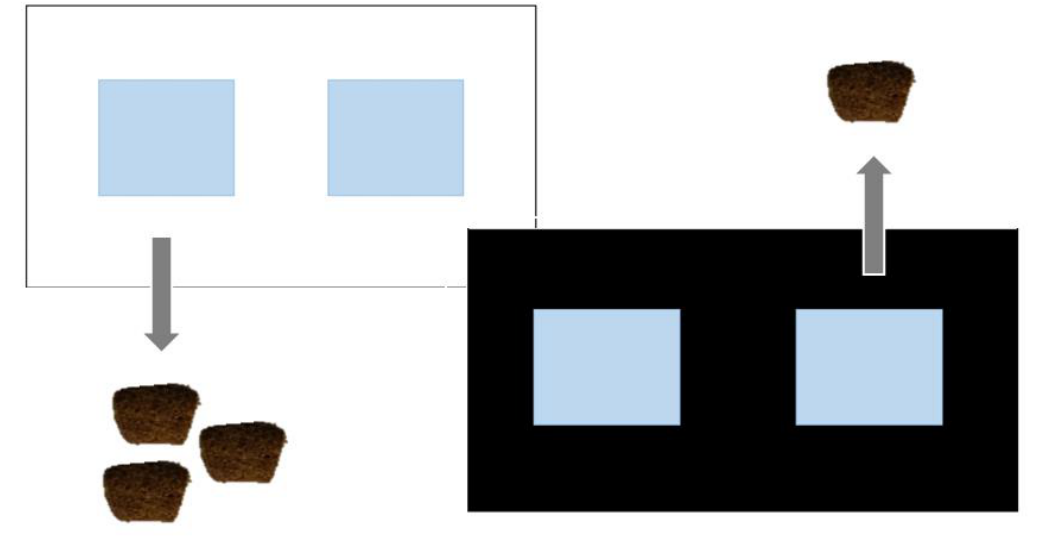
Figure 1. Example training trials; white background trial (top; yielding three pieces of chow), black background trial (bottom; yielding one piece of